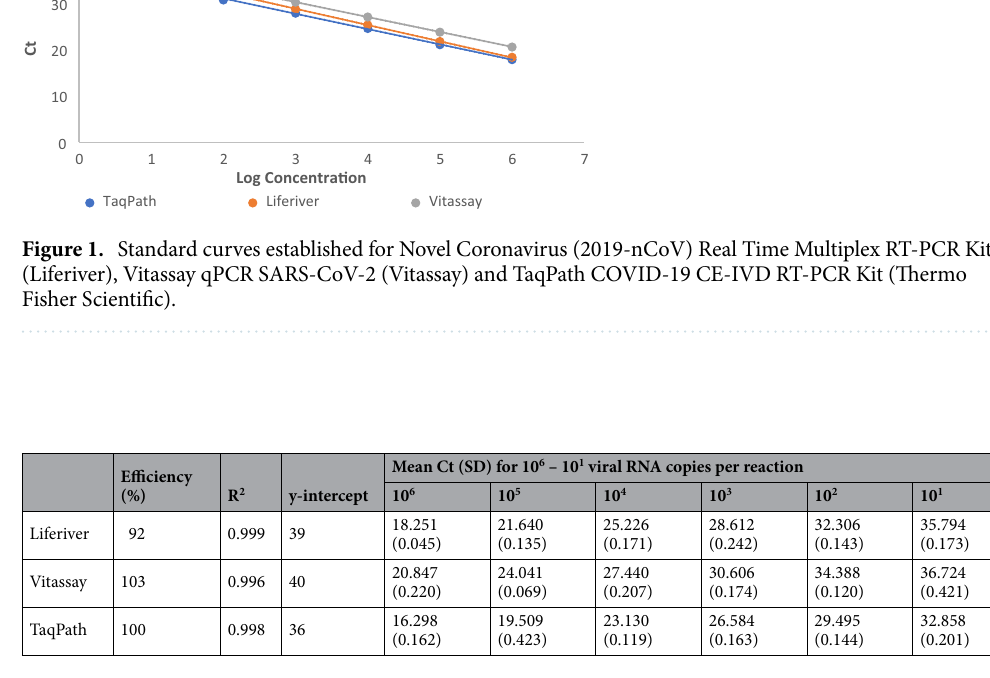
Table 2. RT-qPCR amplification parameters for Novel Coronavirus (2019-nCoV) Real Time Multiplex RT-PCR Kit (Liferiver), Vitassay qPCR SARS-CoV-2 (Vitassay) and TaqPath COVID-19 CE-IVD RT-PCR Kit (Thermo Fisher Scientific). R 2 —the correlation coefficient, SD—standard deviation.